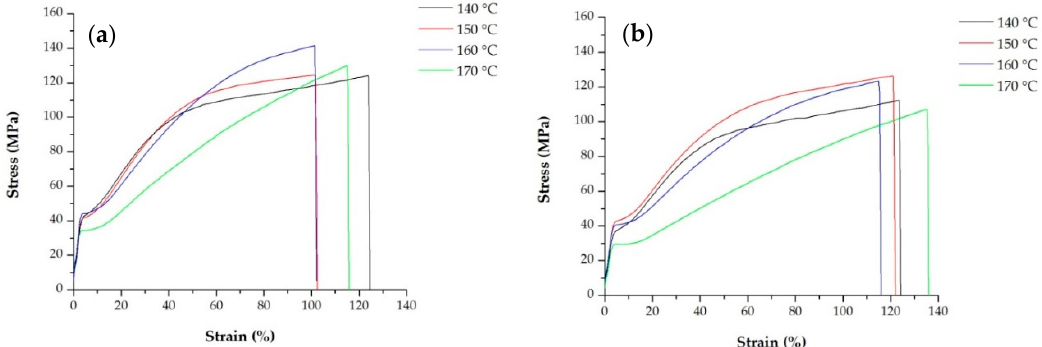
Figure 7. Stress-strain curves of samples ( a ) H-20B and ( b ) H-10R. Precursor films annealed at four different temperatures.